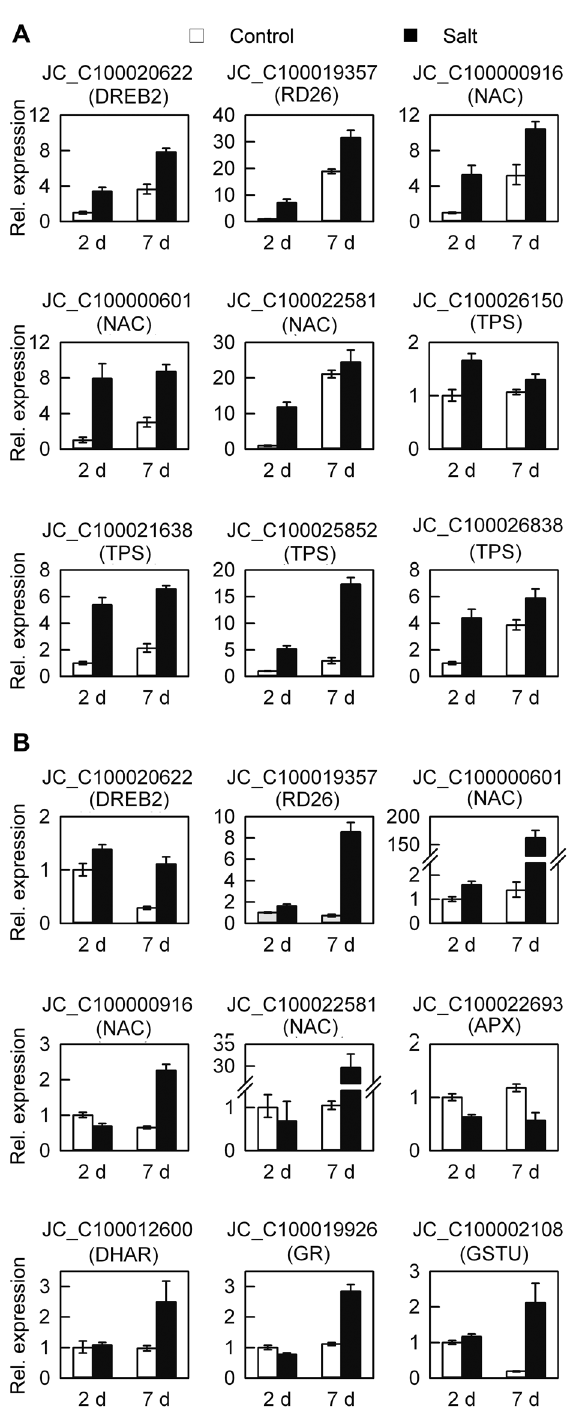
Figure 3. Quantitative RT-PCR analysis of selected genes under salt stress. Relative expression folds of selected genes in (A) roots and (B) leaves after the onset of salt stress. Error bars indicate the SD for three independent replicates. APX, ascorbate peroxidase; DHAR, dehydroascorbate reductase; DREB2, dehydration response element- binding protein 2; GR, glutathione-disulfide reductase; GSTU, glutathi- one S-transferase TAU family; NAC, NAM, ATAF1;2, CUC2; RD26, responsive to desiccation 26; TPS, trehalose-phosphatase/synthase.